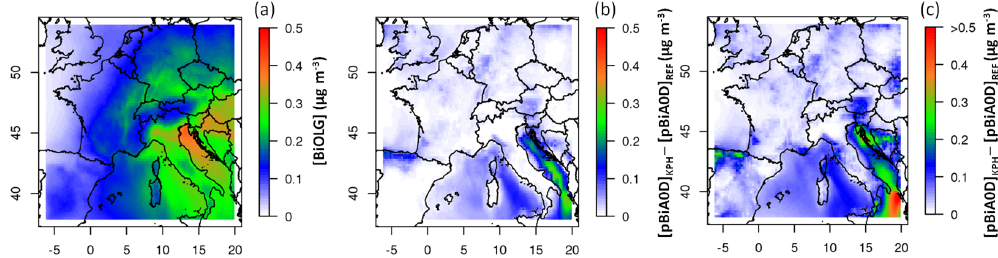
Figure 5. Average modeled oligomer concentration fields from monoterpenes in the KIN (a) and KPH configurations considering both deliquescent (b) and metastable mode (c) for the period of 20 July–3 August 2006.